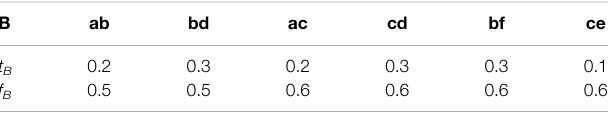
FIGURE 2 | Equitable isolated